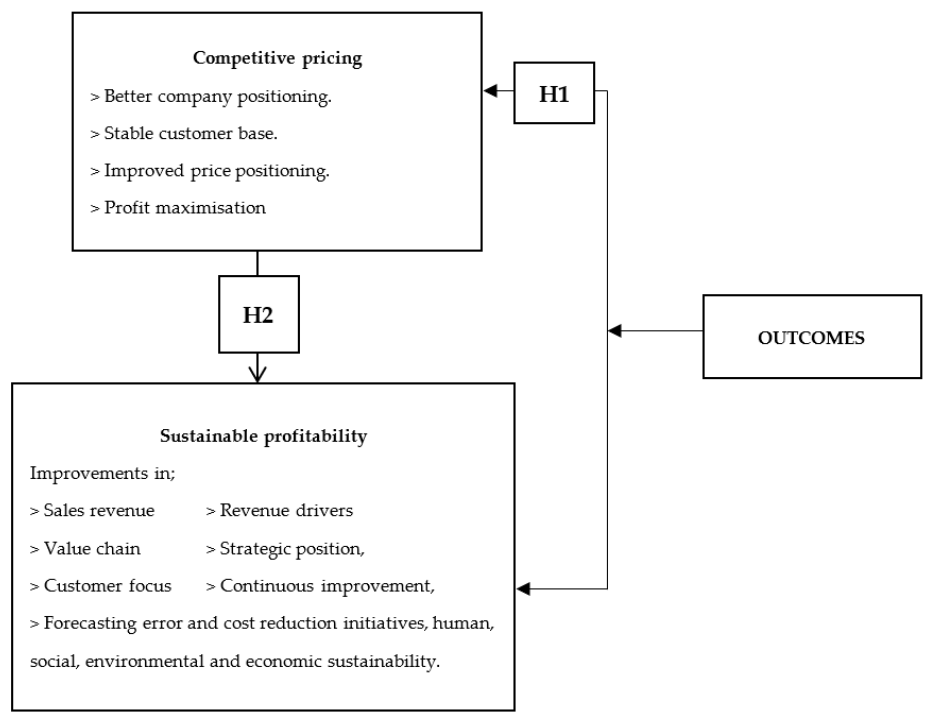
Figure 2. Conceptualization flow chart of the relationship between resource consumption accounting, competitive prices and sustainable profitability.